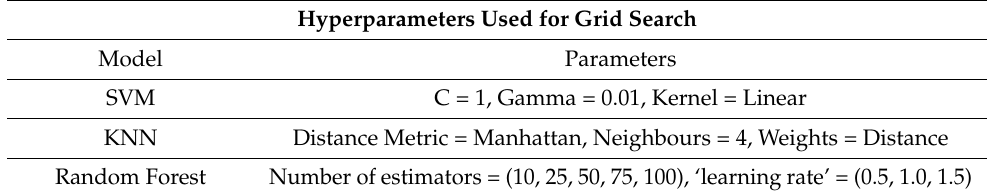
Table 16. Hyperparameters optimized for each model.